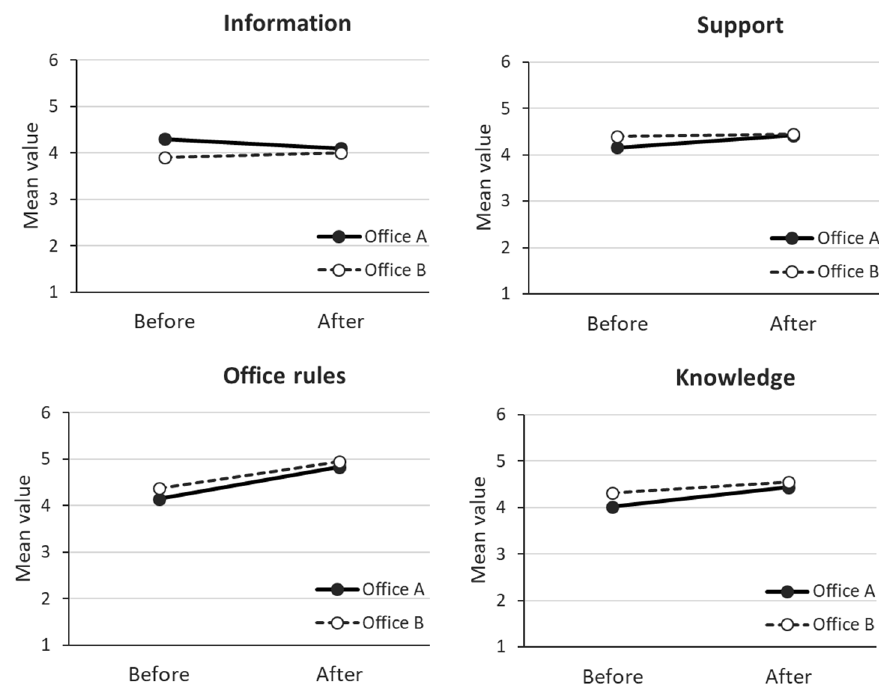
Figure 3. The mean values among Office A and B for satisfaction with perceived knowledge, understanding office rules, information, and support before and after relocation.